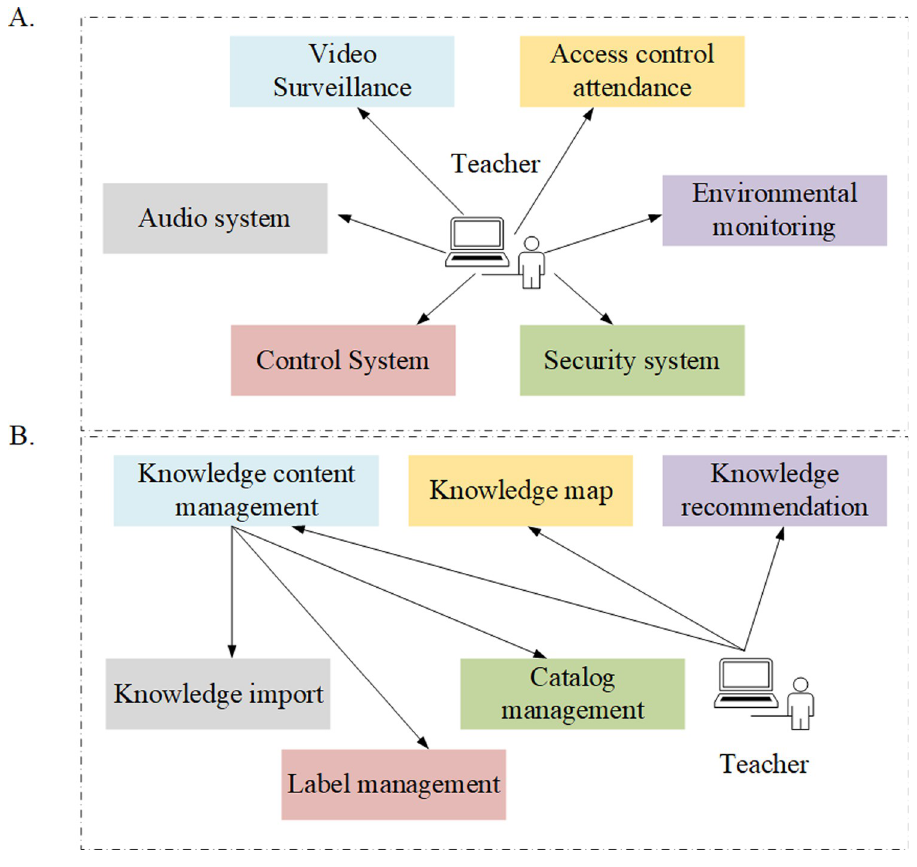
Fig 2. Analysis of teacher equipment and content management